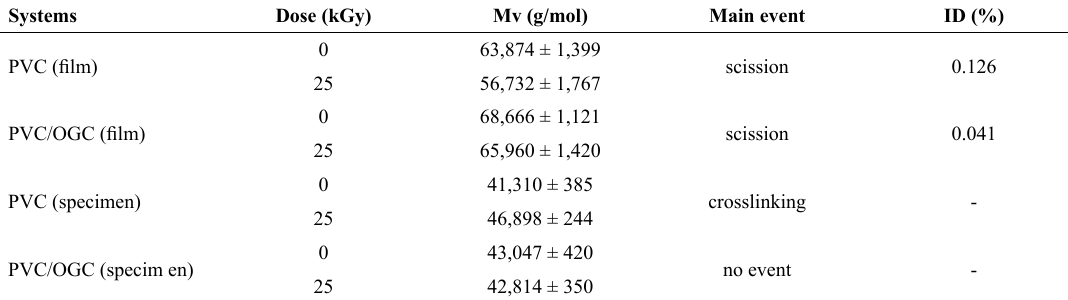
Table 1. Viscosity results obtained for PVC/OCG